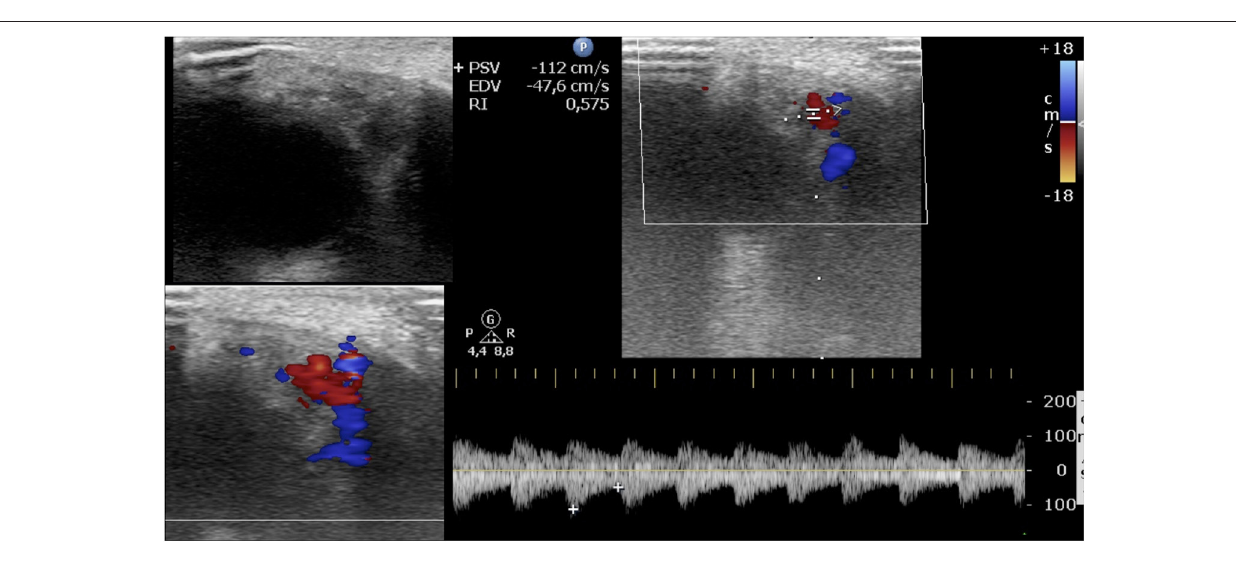
FIGURE 2 | The same infantile hemangioma of Figure 1 . Latest ultrasound evaluation with detectable color Doppler signals after 3 months of oral propranolol. Post-treatment images show a smaller mass with heterogeneous echogenicity; at color Doppler, the vascularization is reduced, and the resistive index is